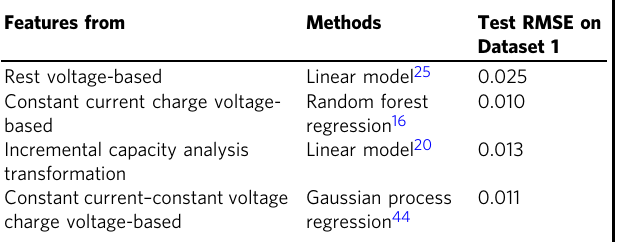
Fig. 4 Results of battery capacity estimation with the input of three features [Var, Ske, Max] by different estimation methods. The capacity results are uniformized by the nominal capacity for comparison. root-mean-square error (RMSE) of battery capacity estimation ( a ), test results of estimated capacity versus real capacity by ElasticNet ( b ), XGBoost ( c ), and Support Vectors Regression (SVR) ( d ). Fig. 5. The coef fi cient of determination (R 2 ) of each measured Table 2 Test means root-mean-square error (RMSE) of impedance spectrum between the raw and fi tted data is different models using voltage-based features for battery summarized in Supplementary Table 12. All R 2 values are greater capacity than 0.999, indicating the credible fi tting accuracy. All the raw and fi tted impedance data can be found from the data availability.